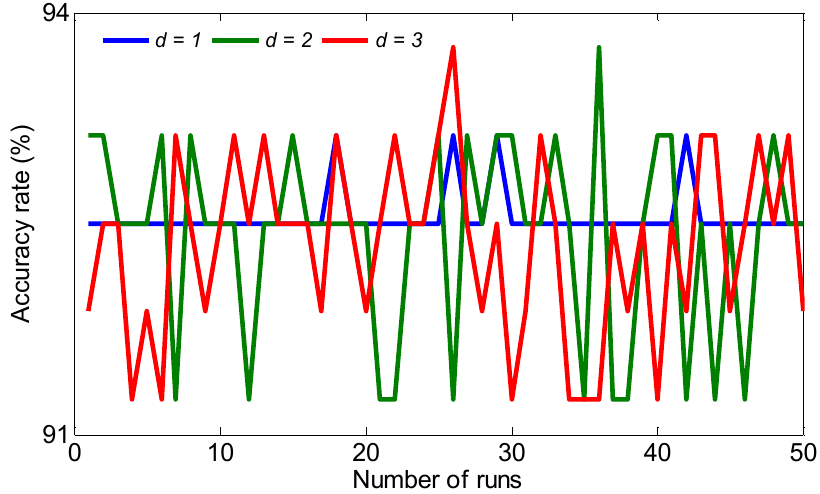
Figure 8. The accuracy rate of the SVM-BA classifier over the running number.